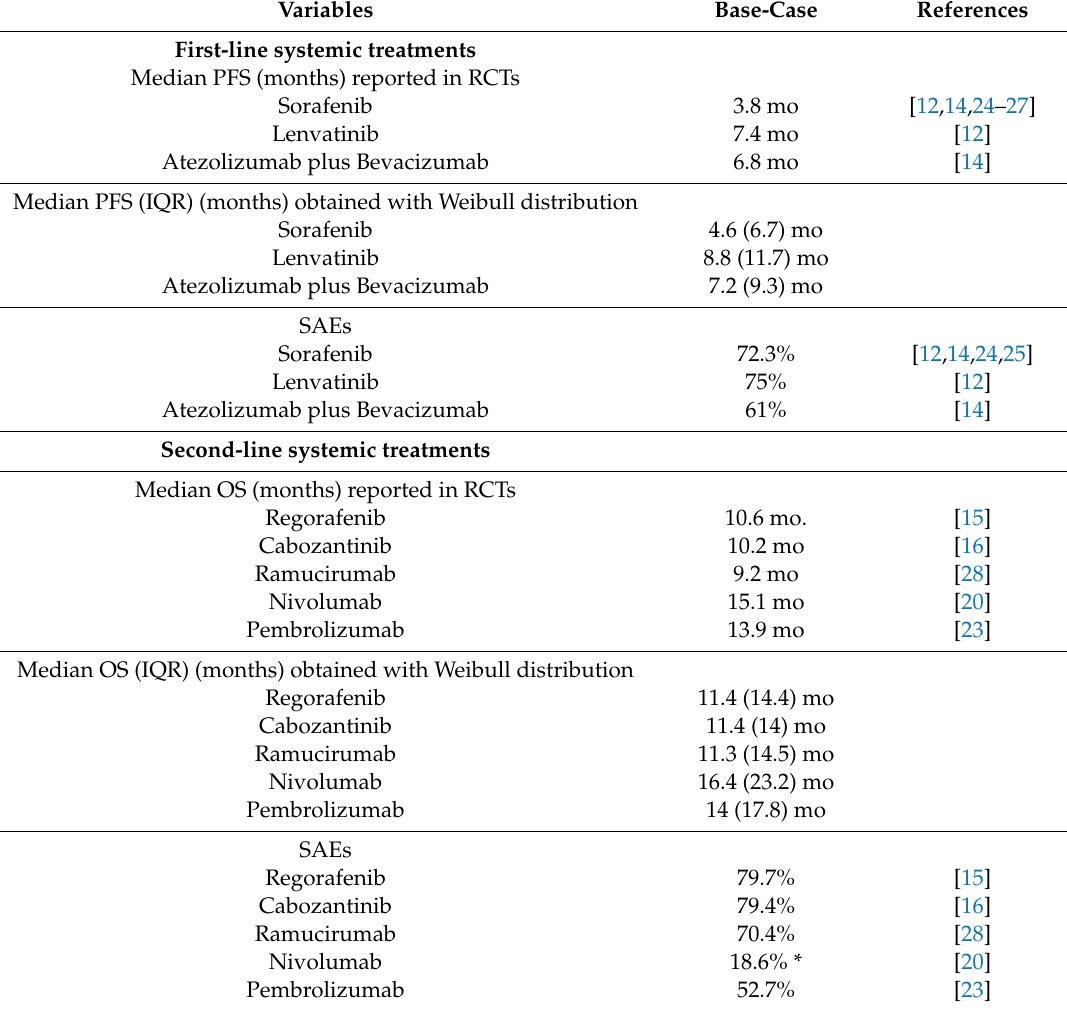
Table 1. Outcomes reported in the clinical trials examined and model